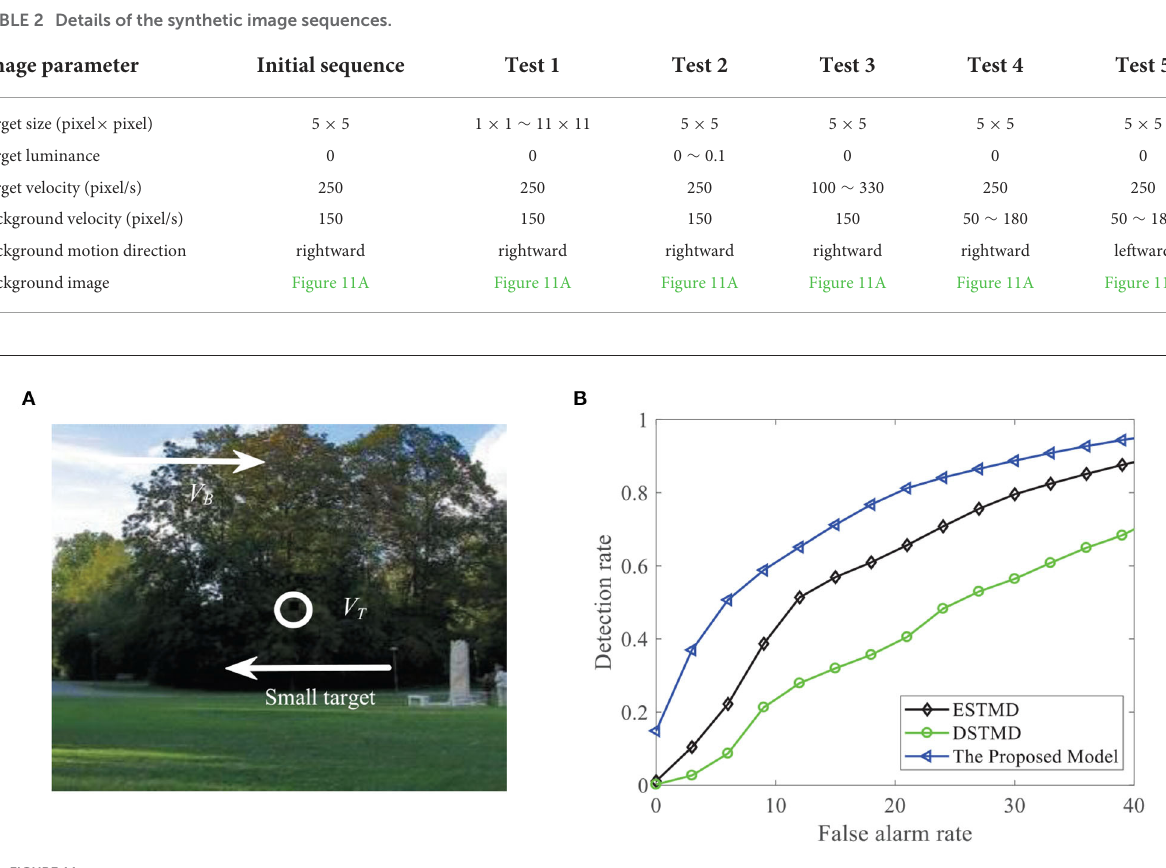
F A curves of the four models for the initial image sequence. −